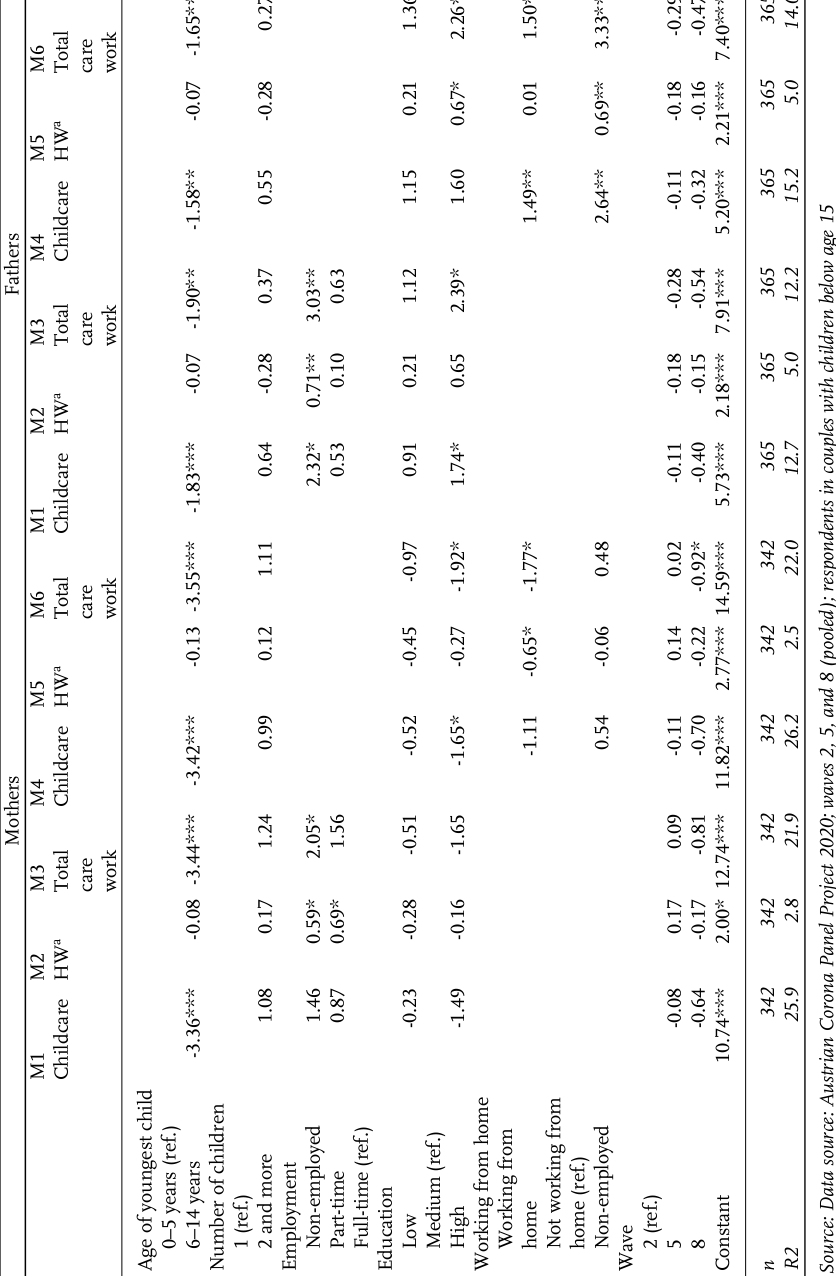
Table 4 : Predictors of mean hours per weekday spent on childcare, housework, and total care work, April and May 2020, linear regression